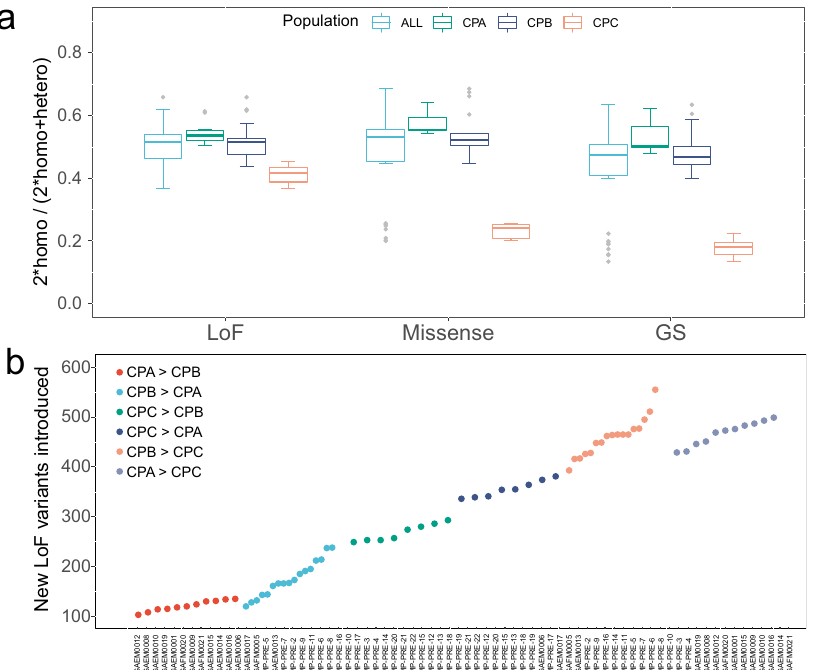
Fig. 5 Mutation load estimation for the pangolin population. a The derived mutations in the coding region include Loss of Function (LoF) mutations, missense mutations, and deleterious missense mutations (GS). Error bars show range of values within 1.5 times the interquartile range. ALL: n = 36. CPA: n = 11. CPB: n = 17. CPC: n = 8. b The predicted number of new LoF variants introduced between individuals from different populations if translocation took